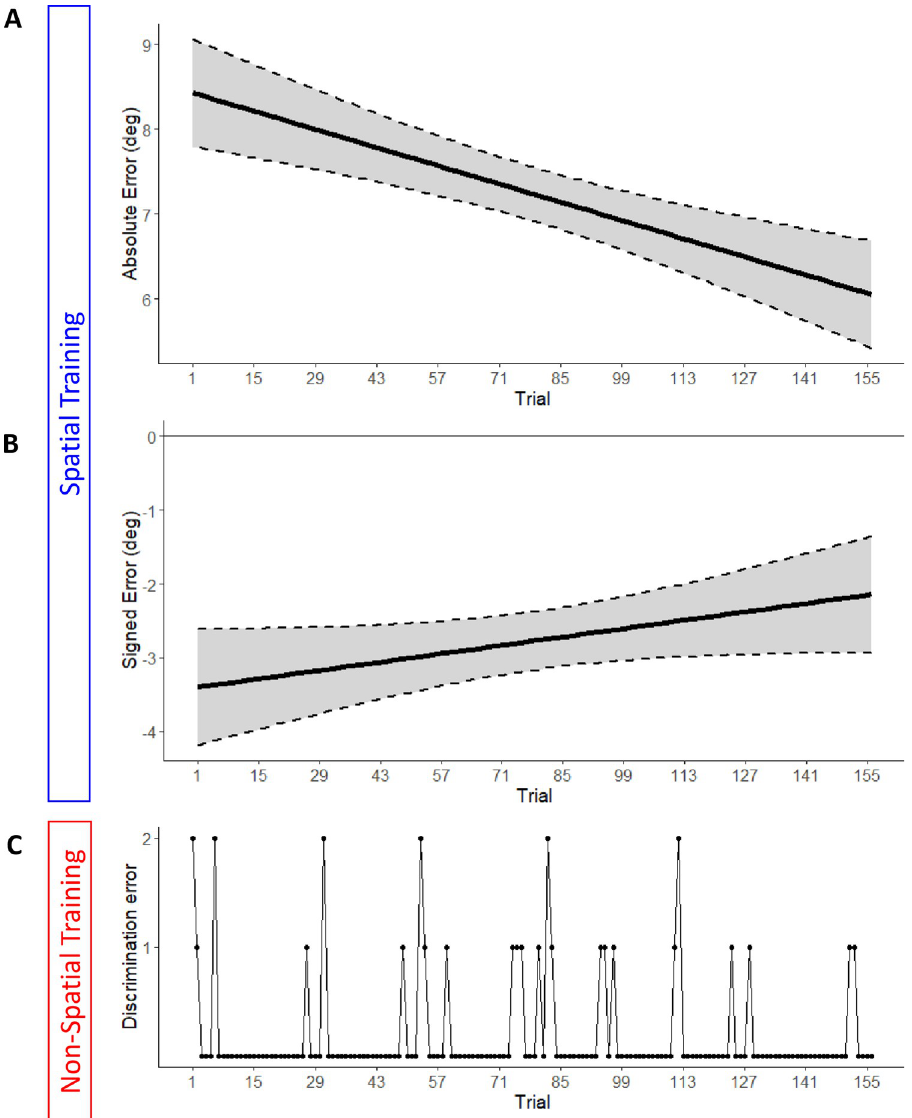
Fig 3. Performance during Spatial and Non-Spatial training. Reduction of absolute (A) and signed (B) error as a function of trial in the Spatial training. (C) Cumulative discrimination error across participants (i.e., number of participants who made a mistake in the trial), shown as a function of trials in the Non-Spatial training. Negative values of signed error indicate a bias toward the unplugged side. Dashed lines indicate the 95% confidence intervals of the overall linear